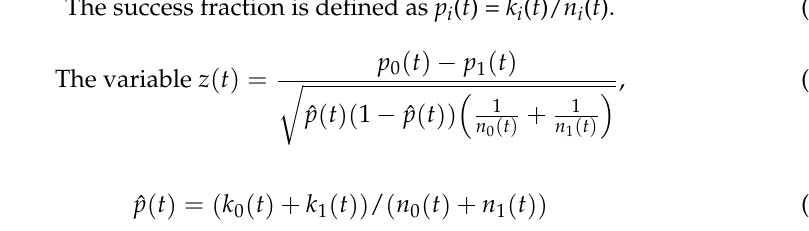
population comprises n i ( t ) measurements with k i ( t ) successes.